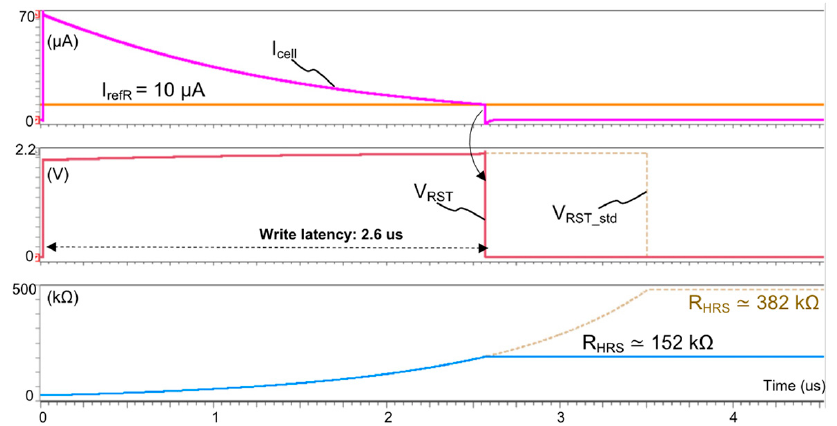
Figure 10. Transient simulation results after a RST operation associated with a reference current value I RefR equals to 10 μ A.